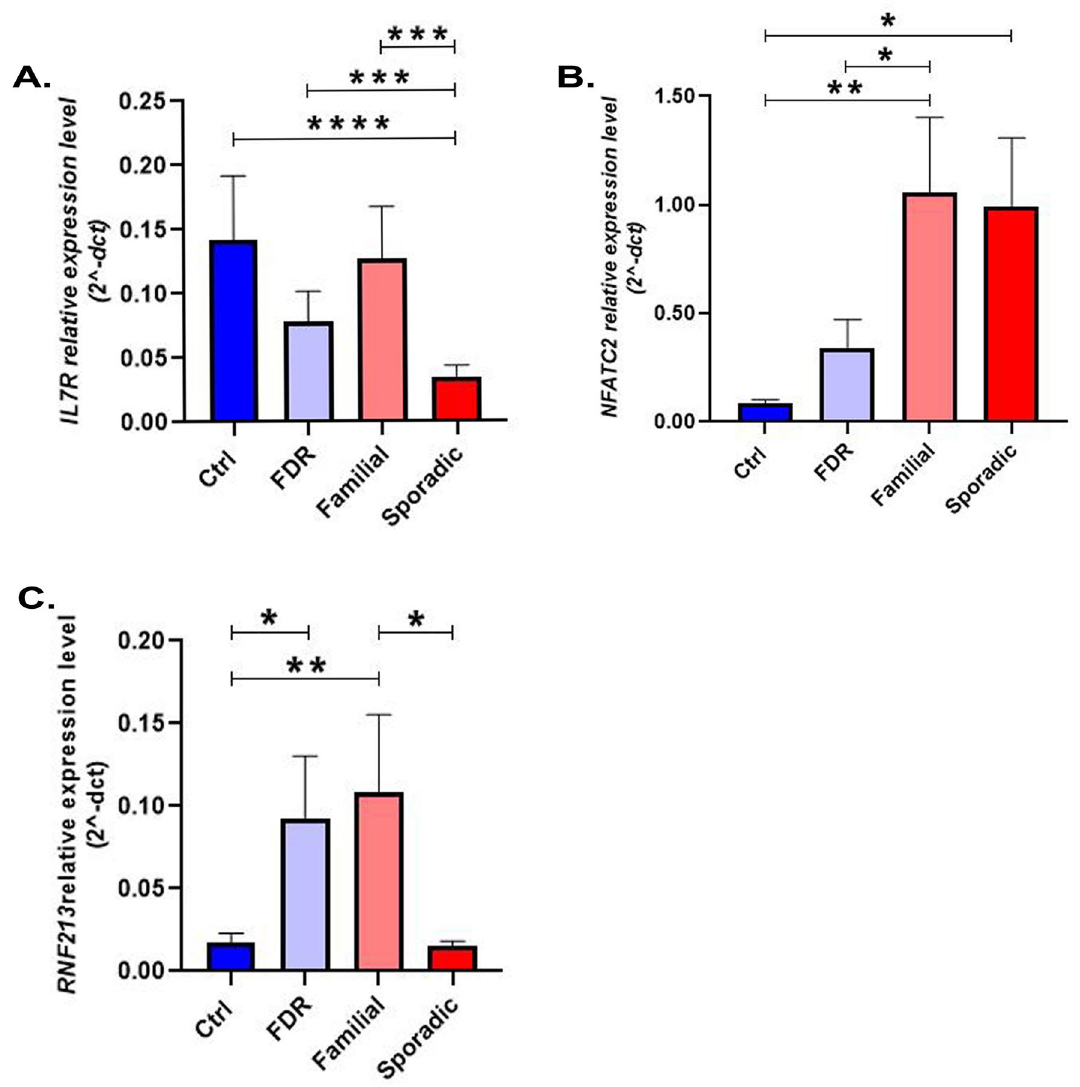
Figure 1. Differential expression levels of ( A) IL7R , ( B) NFATc2 and ( C) RNF213 among genetically separated groups and control group. One-way ANOVA test and in the following, Fisher LSD post hoc test was used for the statistical analysis. Ctrl control group, FDR healthy first-degree relatives of the familial group. Bars represent the standard error of the mean. (*p < 0.05, **p < 0.01, ***p <